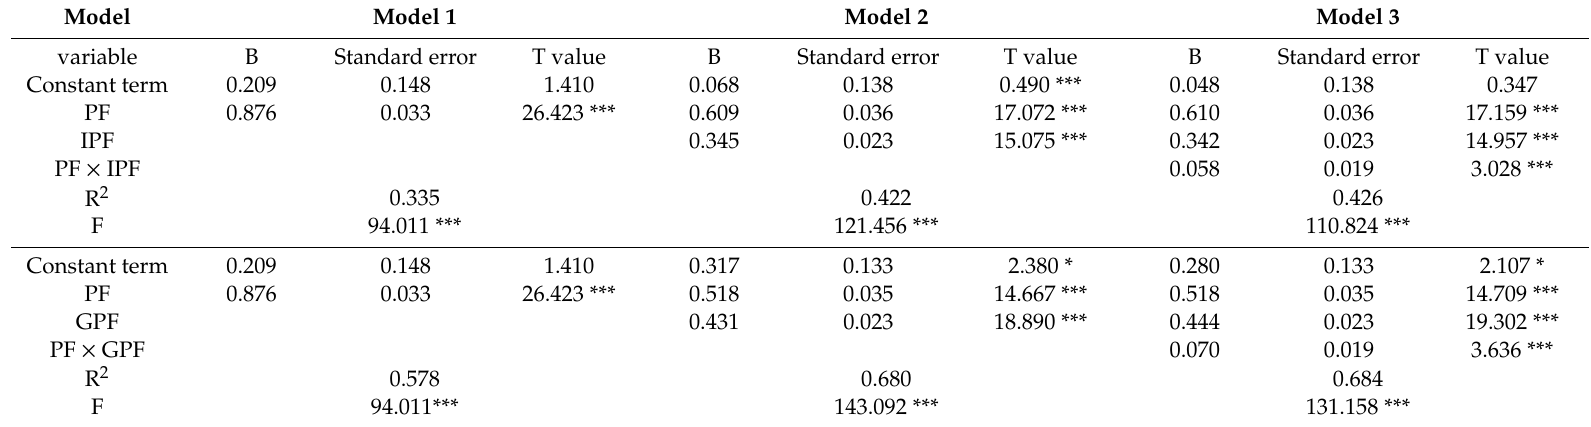
Table 4. Regulating e ff ects of the individual preference framework and the group preference framework on the influence path of product facilities on waste-sorting